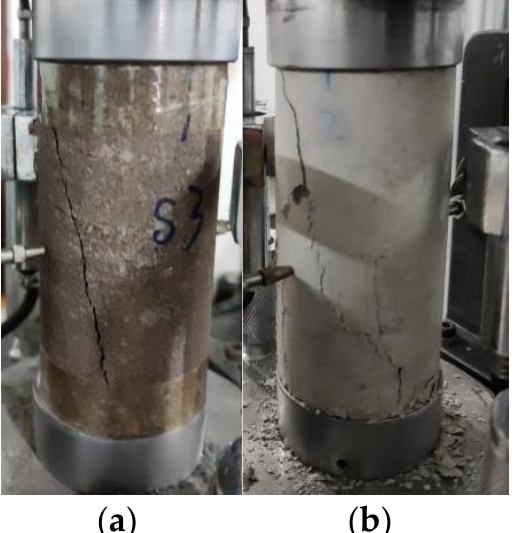
Figure 12. Comparison of failure modes under uniaxial compression. ( a ) Sandstone sample; ( b ) model material.